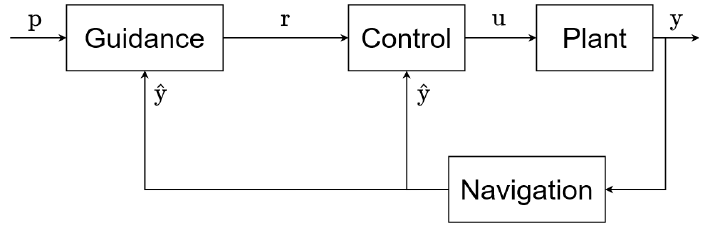
Figure 1. A general guidance–navigation–control (GNC)